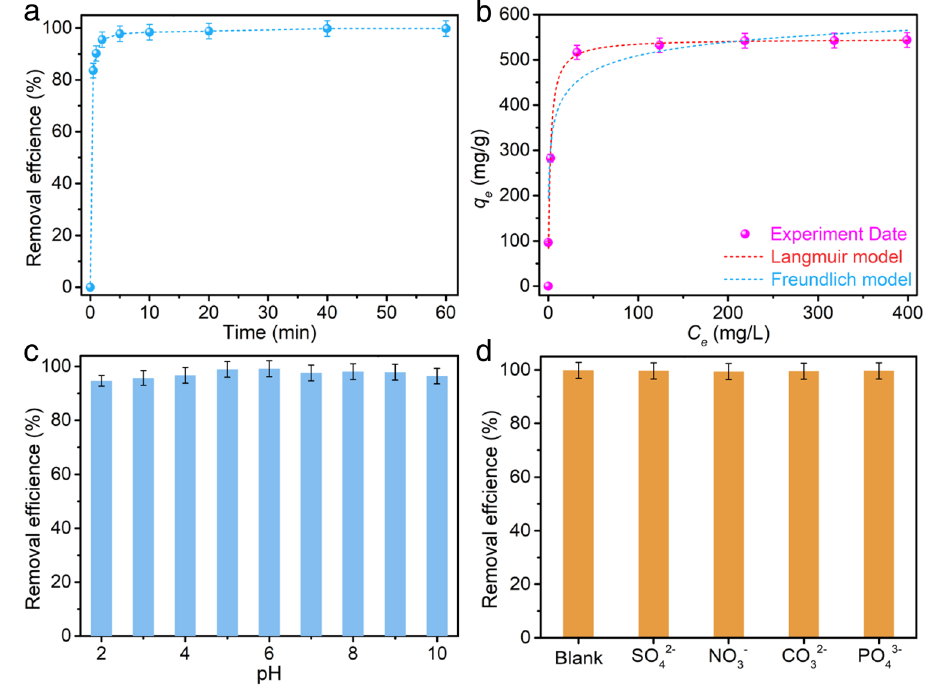
Fig. 4 | ReO 4 − adsorption isotherms and kinetics investigations. a Adsorption kinetics of ReO 4 − by TFPM-PZ-Cl. b Adsorption isotherm of TFPM-PZ-Cl for ReO 4 − capture. c Effect of pH on ReO 4 − capture by TFPM-PZ-Cl. d Removal ef fi ciency of